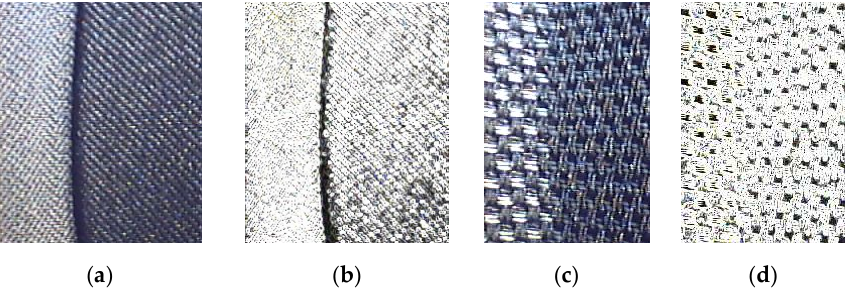
Figure 4. The innovated device called SAHF-W: ( a ) the scheme of device 1—rotating arm; 2—stationary arm; 3—fixed clamps; 4—protractor scale; 5—camera; ( b ) photo of the produced device.